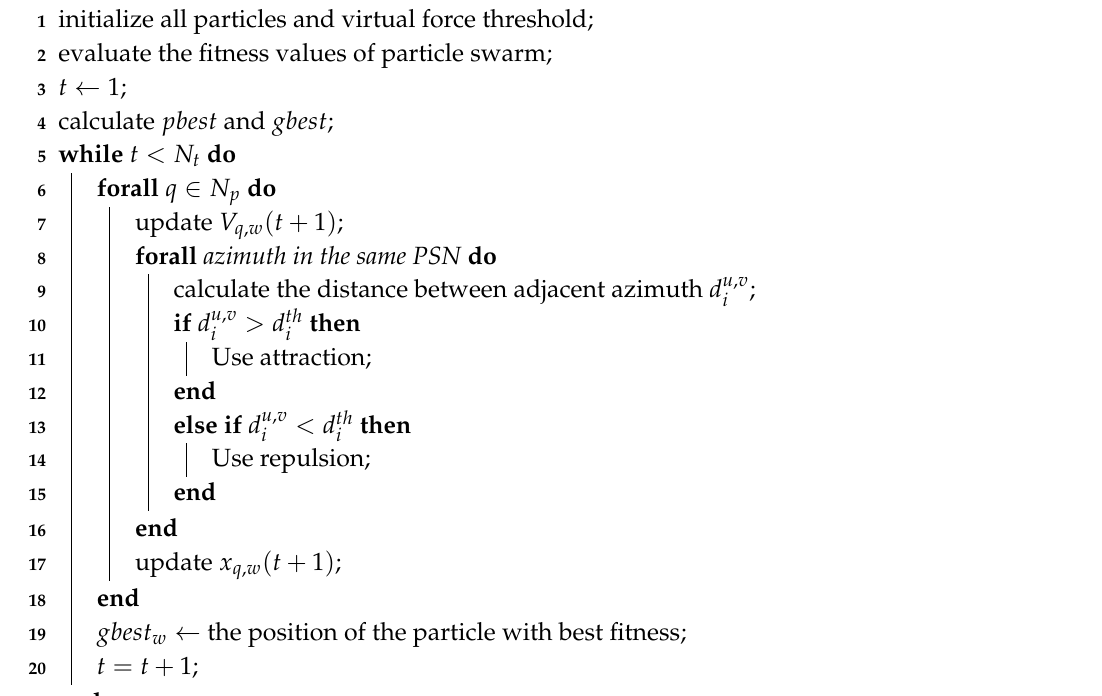
Algorithm 1: AVFPSO algorithm.